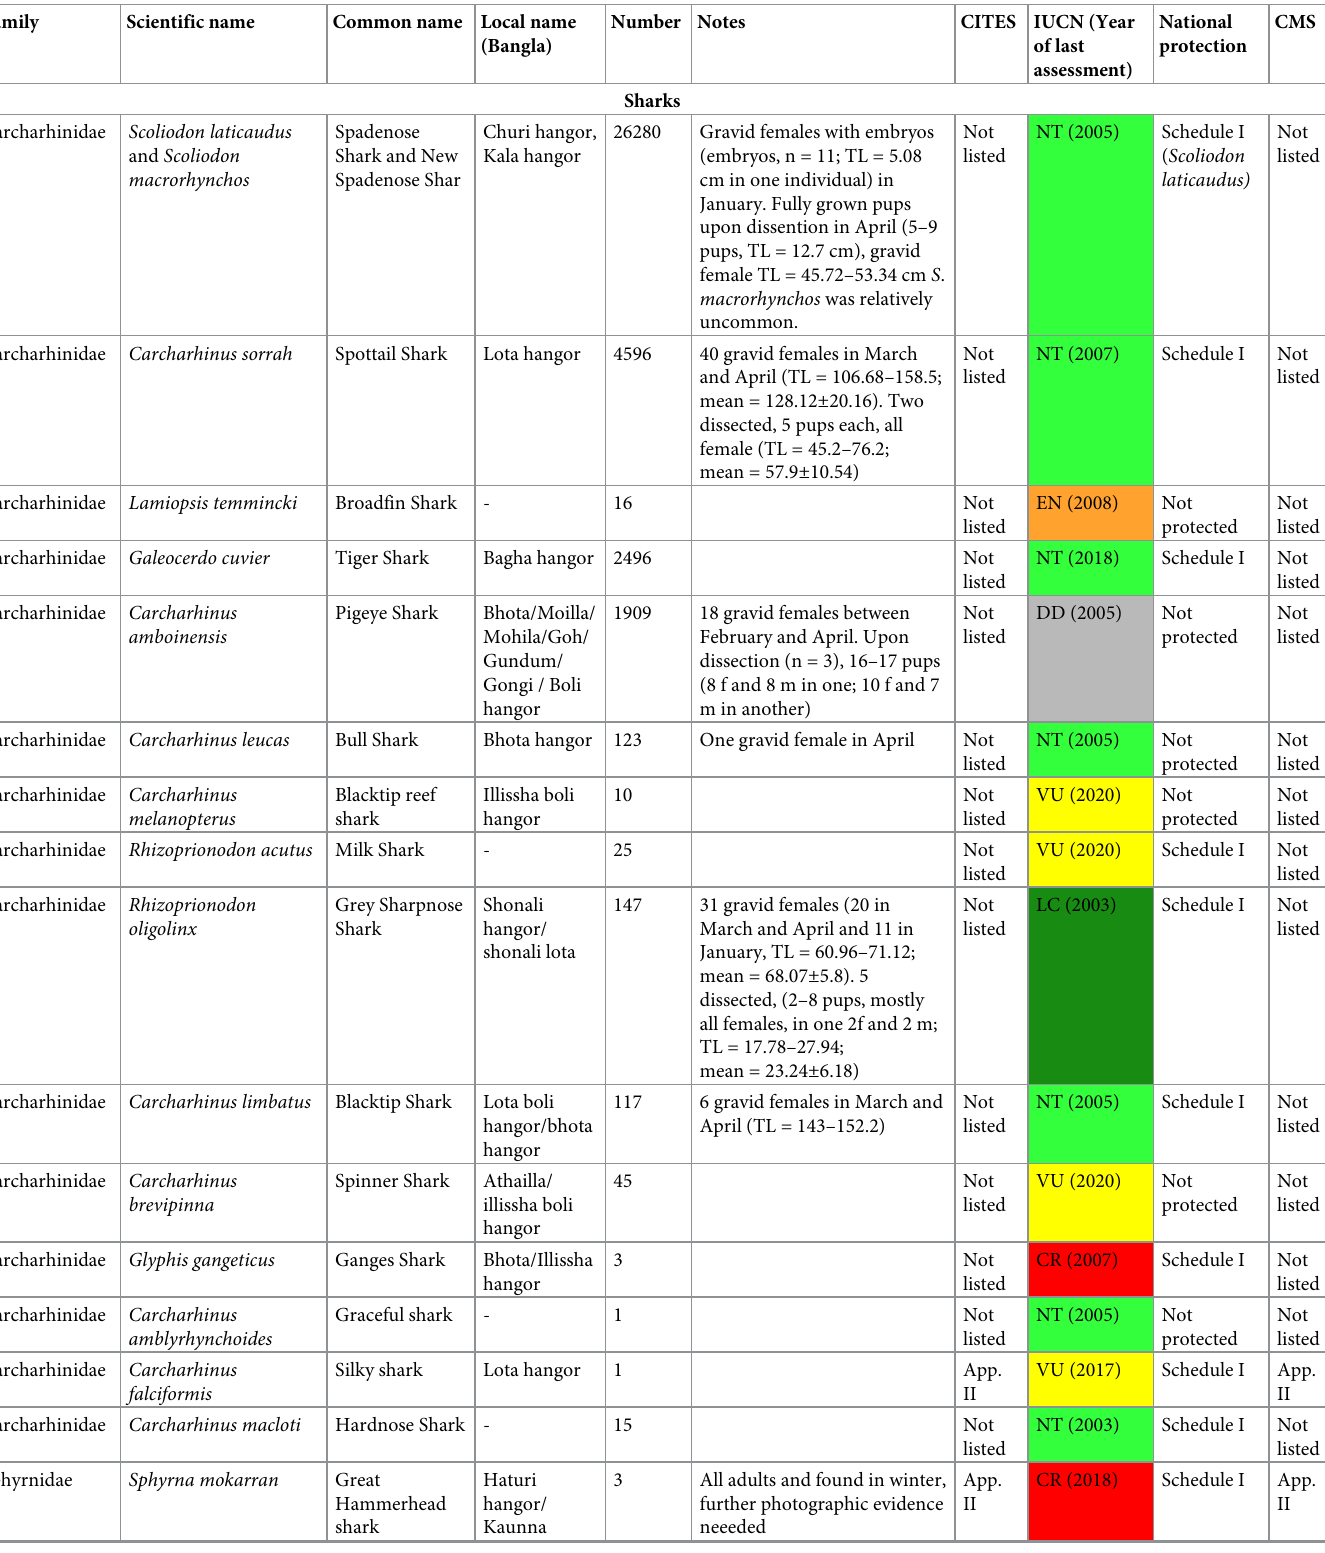
Table 1. List of all shark and ray species recorded between January 2016 and December 2019, Global IUCN Red List of Threatened status (EN: Endangered; NT: Near Threatened; VU: Vulnerable; DD: Data Deficient; LC: Least Concern); NE: Not evaluated), assessment dates, CITES, CMS and National protection status are given with commented on their